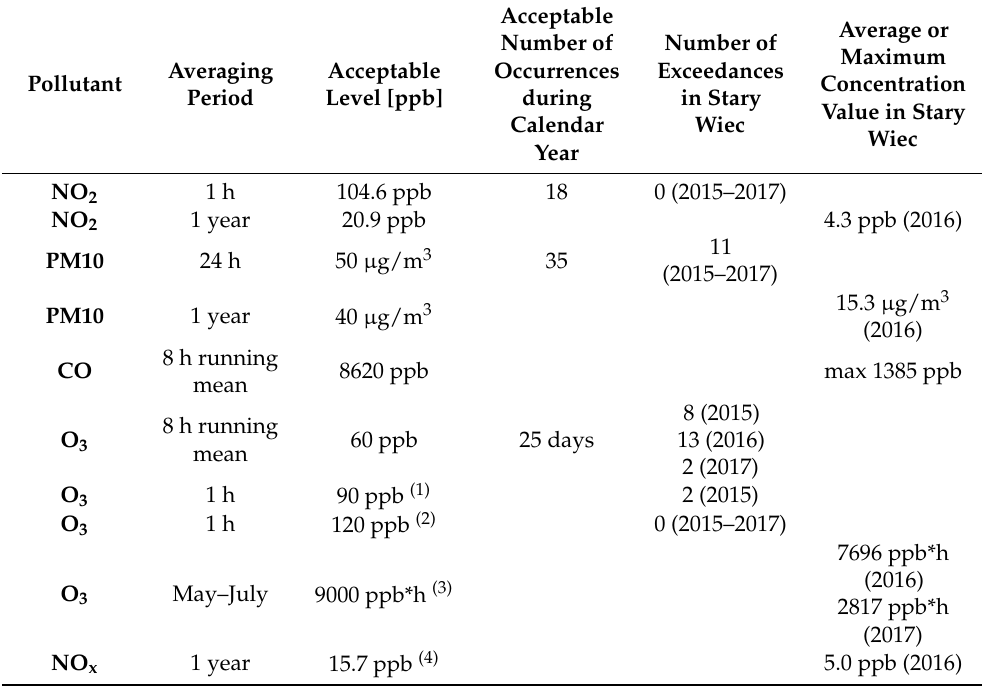
Table 4. Air quality criteria applicable to the pollutants measured at the Stary Wiec station (1) Informa- tion threshold, (2) Alarm threshold, (3) Accumulated O 3 exposure indicator (AOT40), (4) Protection of vegetation. Normal font-standards for human health protection, italics-standards for plant protection. Acceptable Average or Number of Number of Maximum Exceedances Occurrences Averaging Acceptable Concentration Pollutant in Stary during Period Level [ppb] Value in Stary Wiec Calendar Wiec Year 1